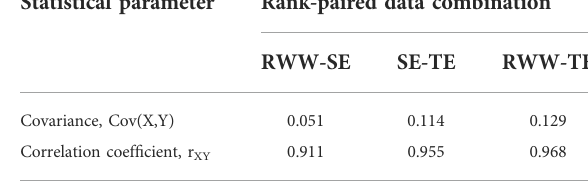
TABLE 2 Rank-paired covariance and Pearson correlation coef fi cient